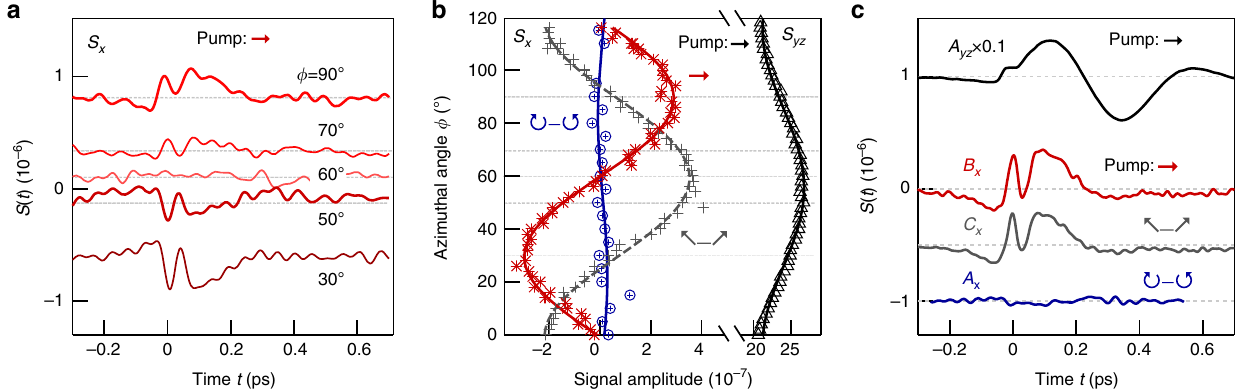
Figure 3 | Azimuth dependence and dominant components of THz signal S x . ( a ) THz signal waveforms at various sample azimuth angles f and for fixed pump polarization. ( b ) Extracted THz amplitude versus f for various pump-polarization settings ( - and differential signals q (cid:2) s and g (cid:2) h ). While both S x and S yz exhibit a 3 f -type-dependent component of comparable magnitude, S yz has a much larger and dominant component independent of f . ( c ) Dominant temporal components of signal sets S yz ( t , f ) and S x ( t , f ) for various pump polarizations, extracted by using equation (2) (see the ‘Methods’